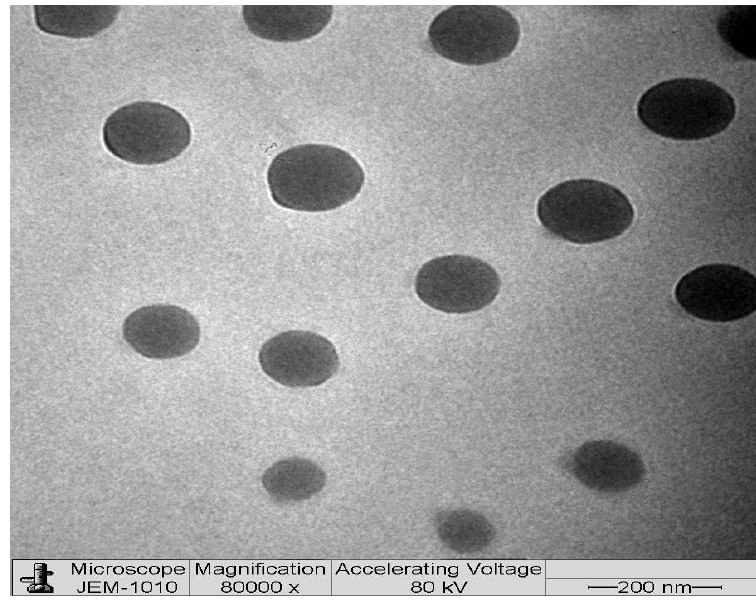
Figure 6. TEM images of optimized DSM-loaded NE